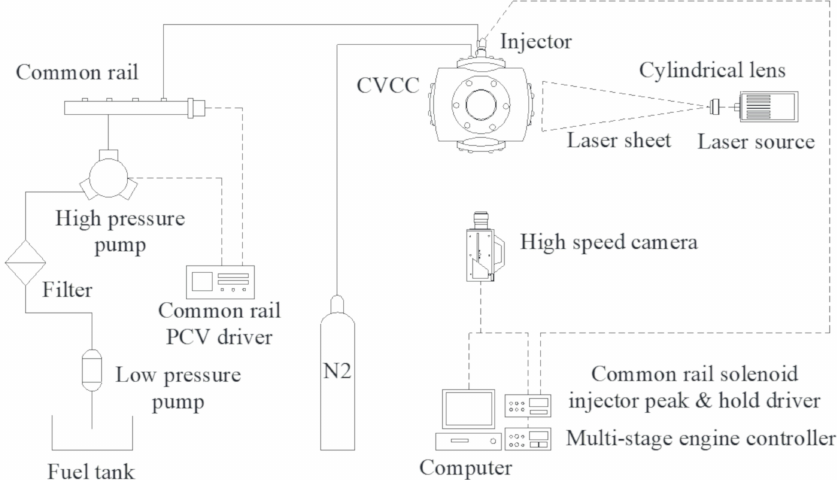
Figure 2. Schematic diagram of the spray image recording system using Planar laser-induced fluorescence coupled with particle-image velocimetry (PLIF-PIV)